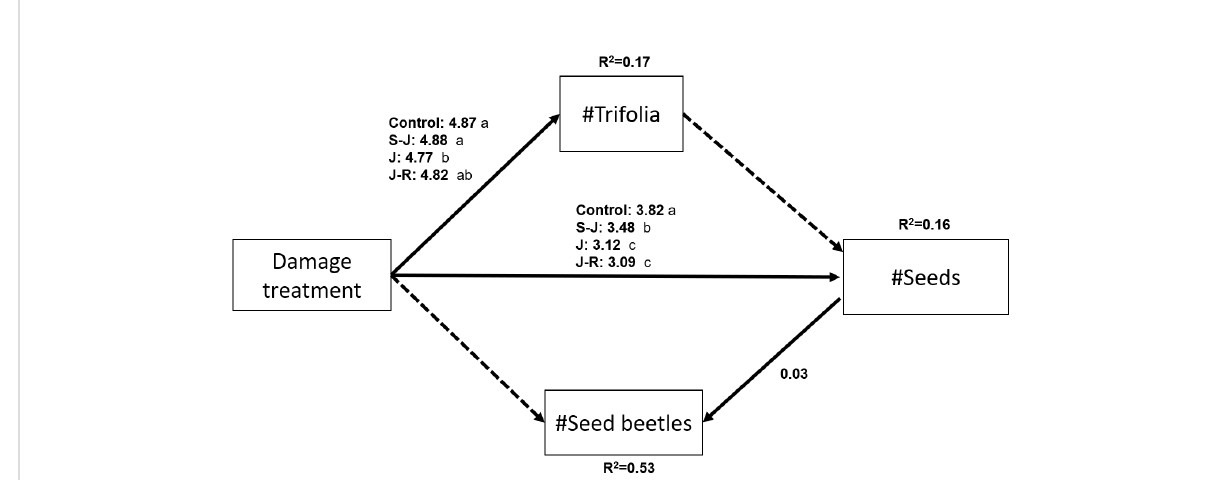
FIGURE 4 Diagram of the structural equation model including pathways between measured variables. Solid arrows indicate statistically signi fi cant positive pathways and dashed arrows indicate no signi fi cant pathways. The differences between treatments are given next to pathways from the Damage treatment variable and different letters indicate signi fi cant differences between groups according to a Tukey ’ s post-hoc test. R square values given for each individual endogenous variables are conditional r squares (excluding random effects). All pathways were analyzed with GLMs and a Poisson error distribution. The estimates are given in the log scale. Model goodness-of- fi t: Fisher ’ s C=0.25, P=0.88.